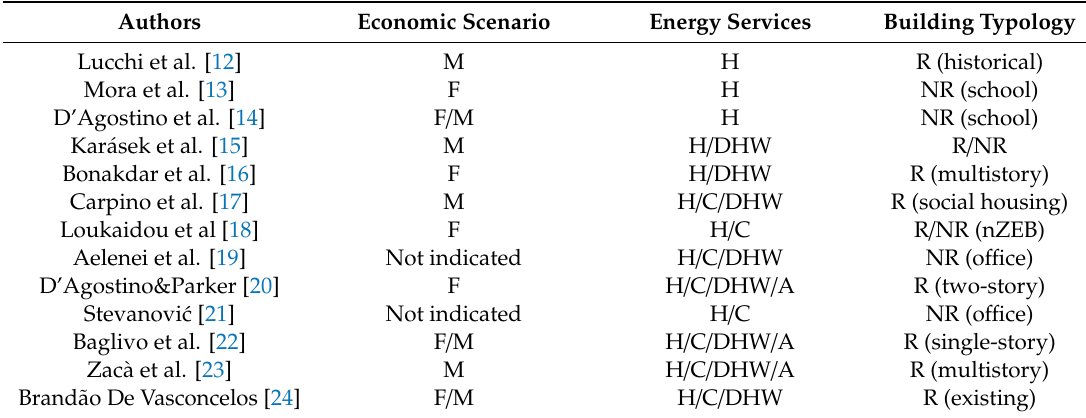
Table 1. Synoptic framework of the main documents found in literature, providing authors,